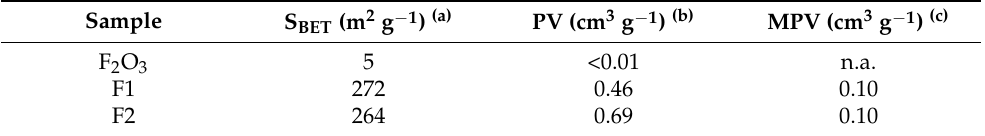
Table 3. Specific surface area (S BET ), pore volume (PV) and micropore volume (MPV) of the samples Fe 2 O 3 , F1 and